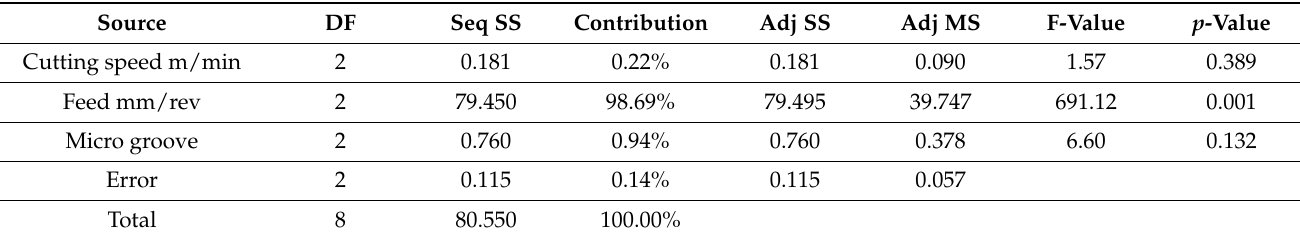
Table 10. Analysis of variance for total cutting power